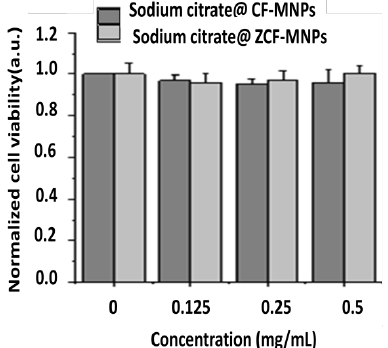
Figure 14. Cytocompatibility tests for sodium citrate@ CF-MNPs and sodium citrate@ ZCF-MNPs in in vitro culture with NIH-3T3.